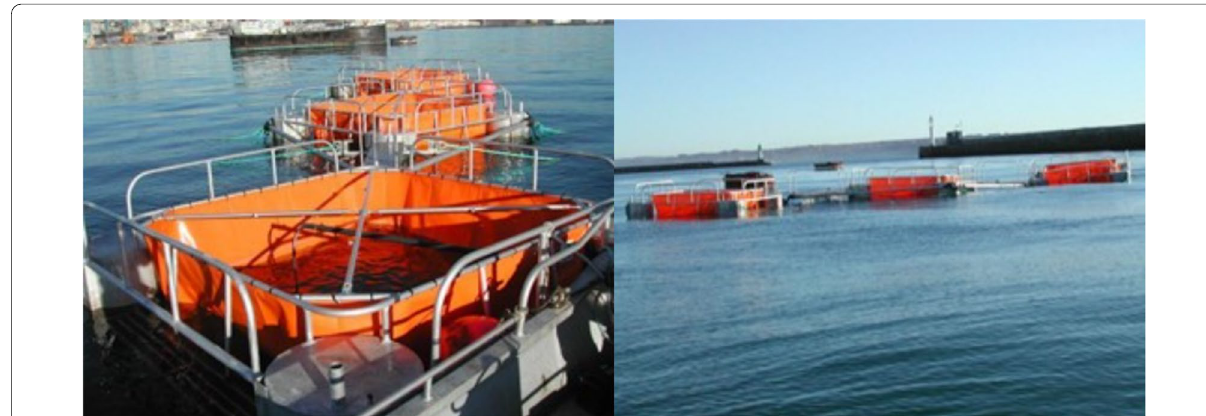
Fig. 2 Current floating cells moored in the entrance of Brest military